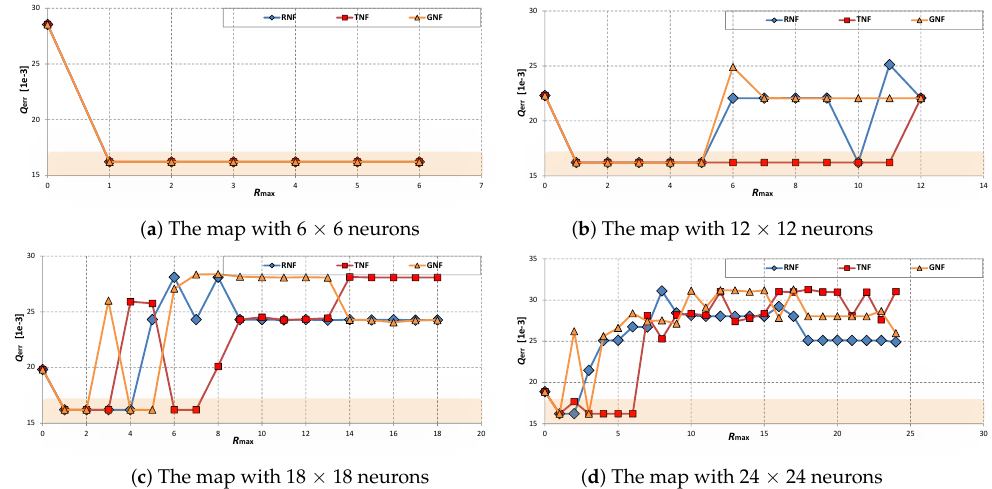
Figure 4. The quantization error as a function of maximum radius, R max , for particular types of neighborhood function, for the Rect8 topology and 2-D data regularly distributed.